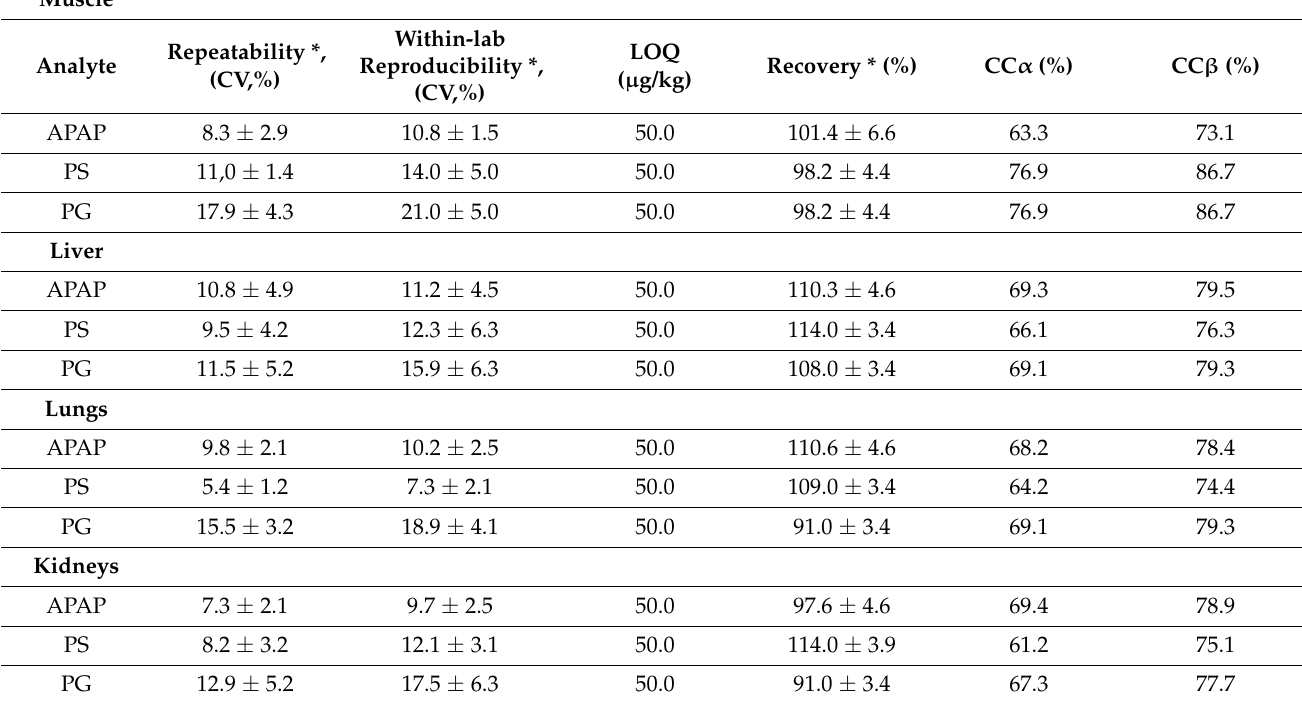
Table 2. Validation